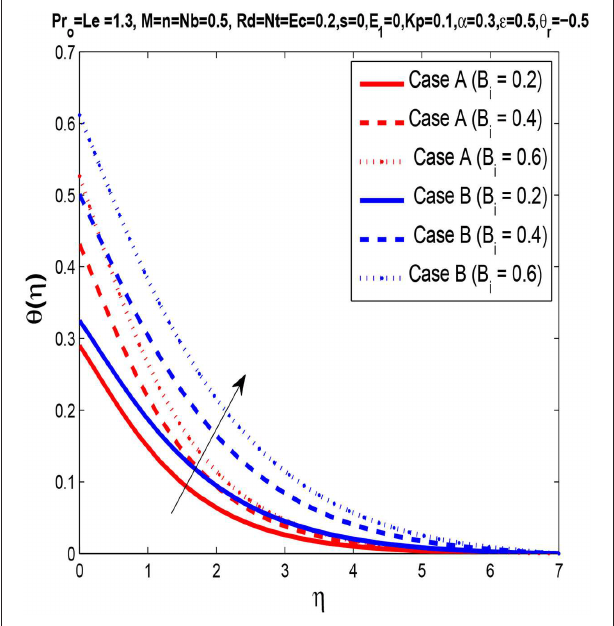
FIGURE 6 | Temperature profile θ ( η ) for different values of Rd .